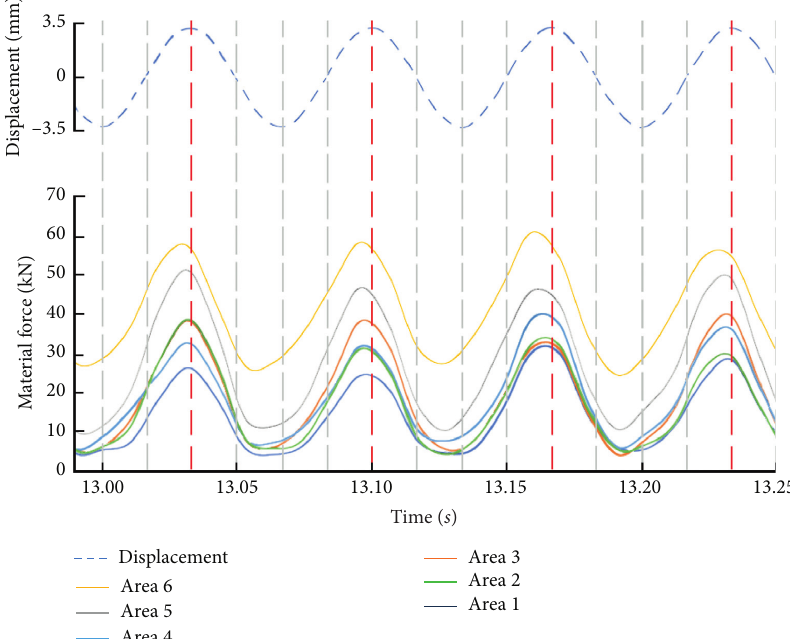
Figure 3: The time-domain corresponding relationship between vibrating feeder motion and materials